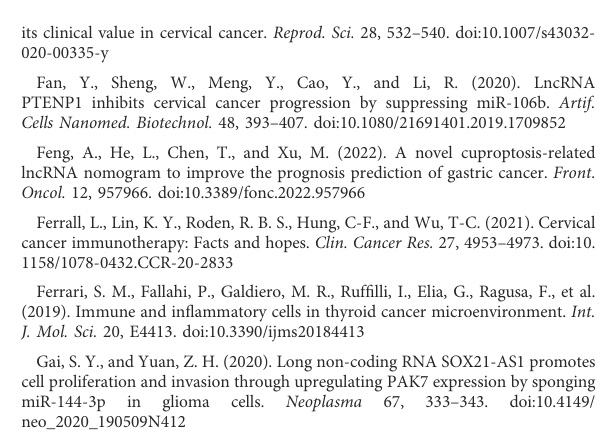
SUPPLEMENTARY FIGURE S1 PFS of the CESC cohort. SUPPLEMENTARY FIGURE S2 DEGs of high- and low-risk groups. SUPPLEMENTARY FIGURE S3 GO enrichment